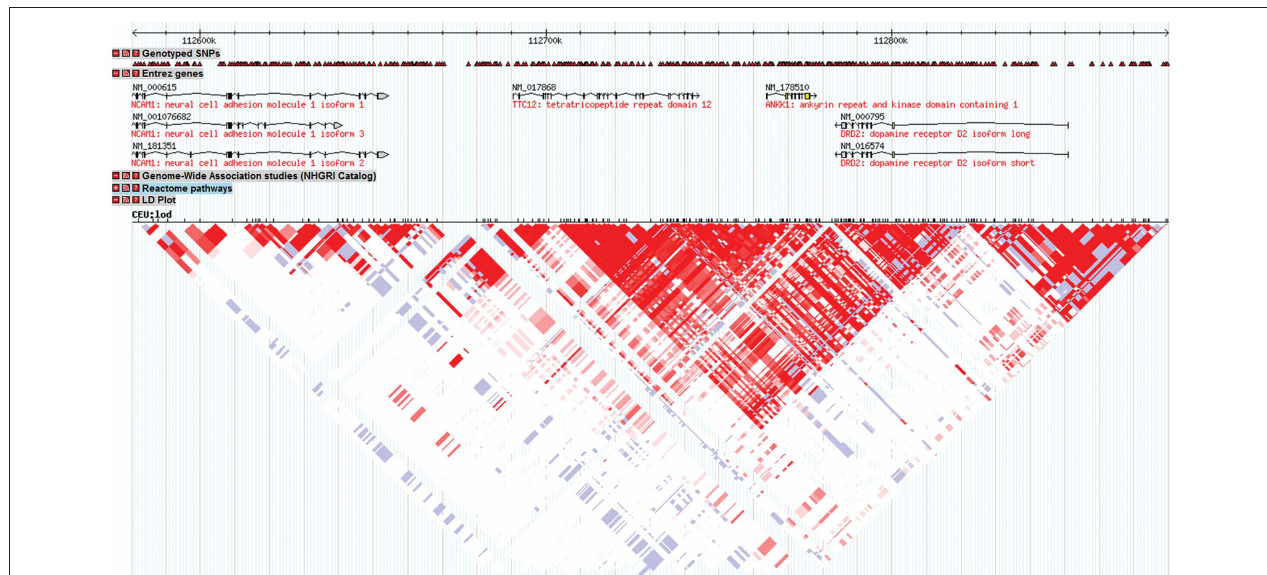
Figure 3 | Screenshot from Haploview (Barrett et al., 2005) showing the linkage disequilibrium structure surrounding the DrD2